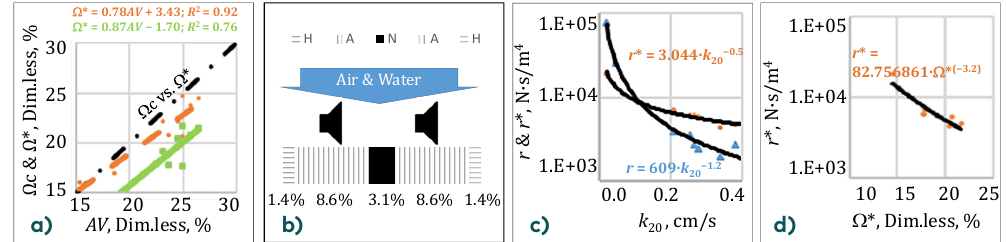
y Fig. 11a – measured and most probable (i.e., derived through the optimi- zation) porosities (